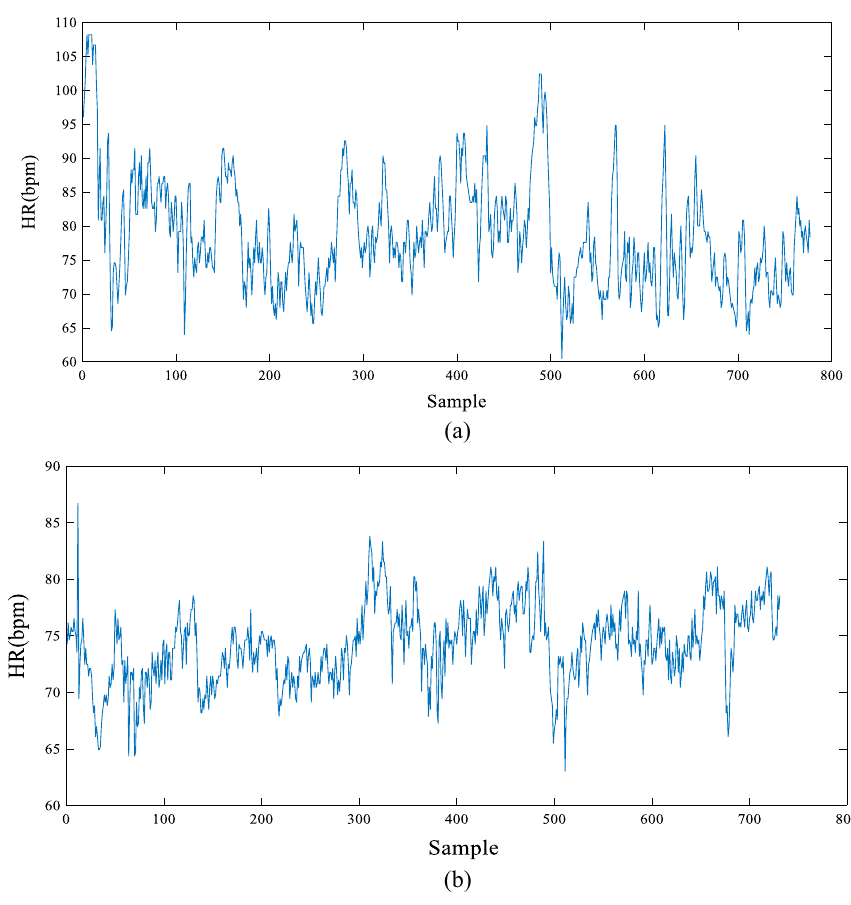
Fig. 3 a HRV signal extracted from normal signal and b HRV signal extracted from SCD